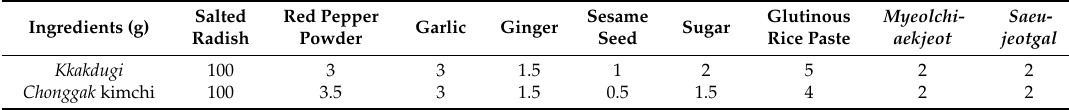
Table 1. Ingredients used for preparation of Kkakdugi and Chonggak